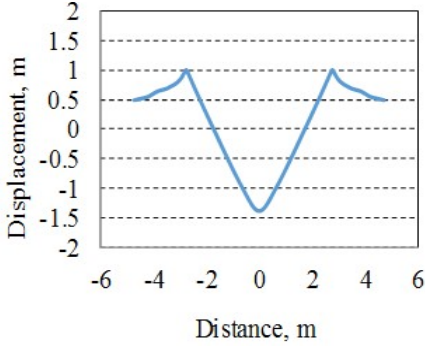
Figure 8: Crater shape at 0.03 second.